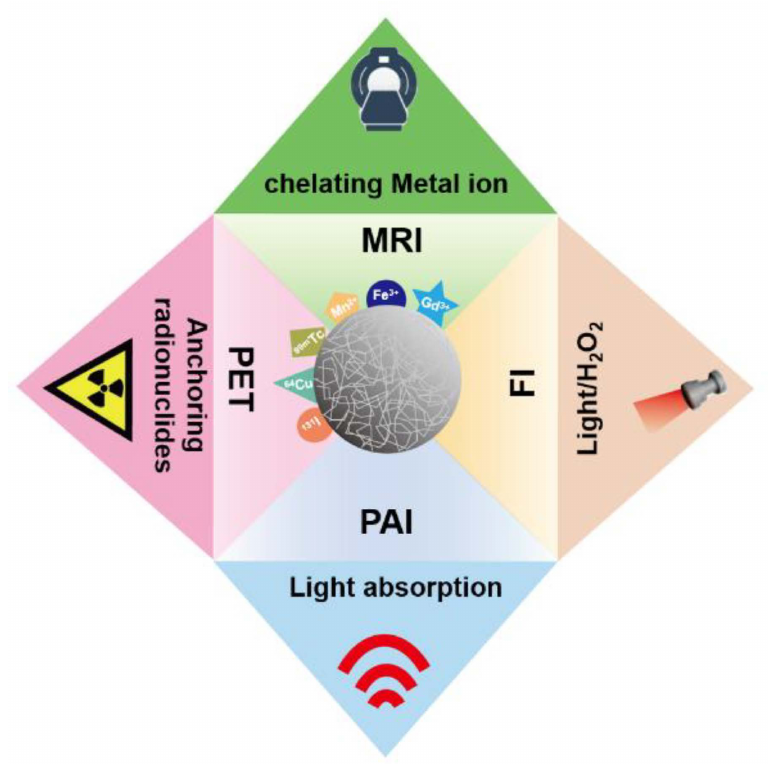
Figure 4. The main bioimaging application of melanin-like